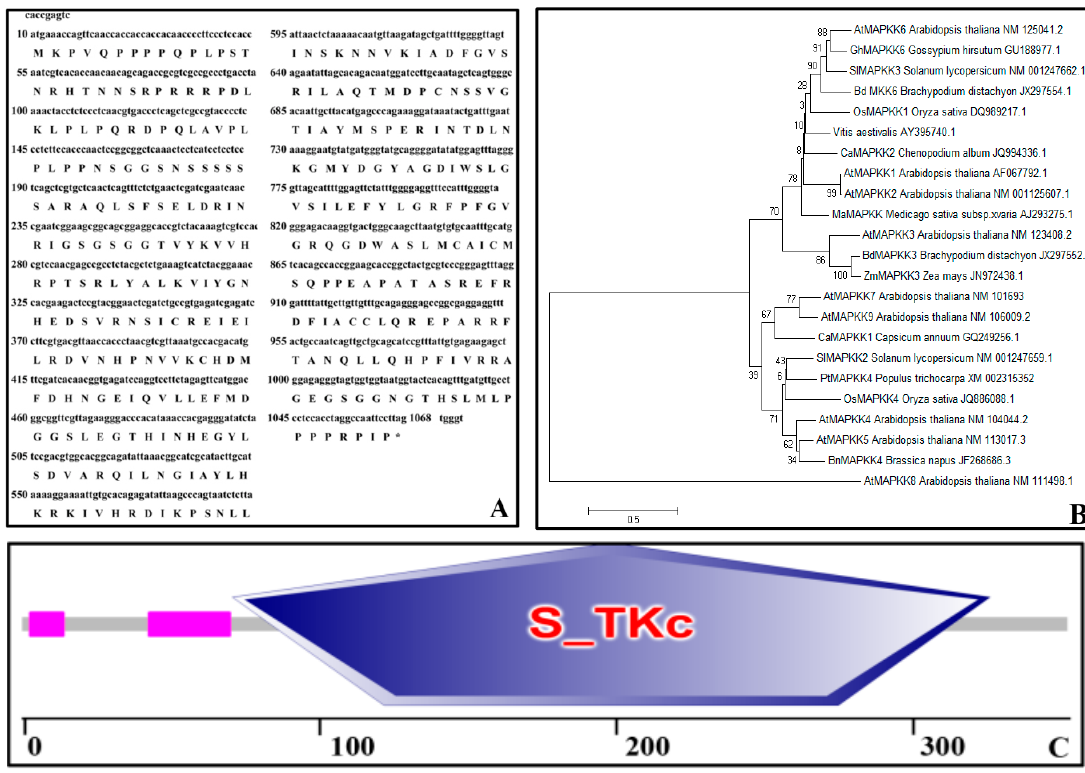
Figure 1. Bioinformatics analysis of PtMAPKK4 sequence. ( A ) Analysis of the open reading frame (ORF) and the coding amino acid sequence of the PtMAPKK4 gene; ( B ) Neighbor-joining phylogenetic tree of the MAPKK gene family, as created by DNAMAN, Bootstrap value (above 50%) supports from 1000 replicates are indicated at each branch with a bootstrap value of 1000, scale is 0.05; ( C ) The S-TKc conserved domain, a sequence feature of the serine/threonine protein kinase family, was displayed by SMART.